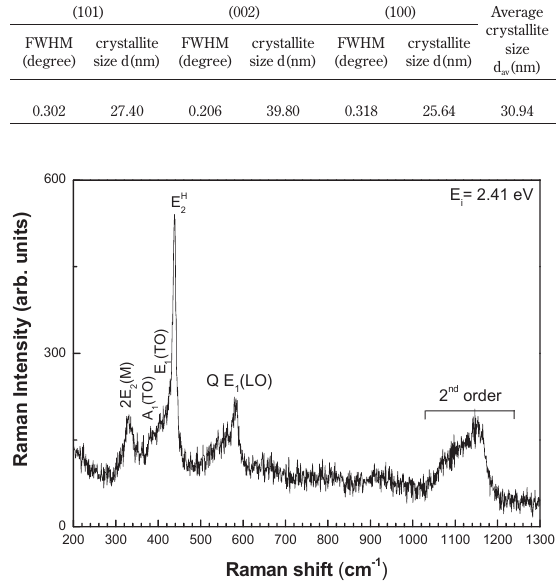
Fig. 3 Room-temperature Raman backscattering spec- trum of the nanocrystalline ZnO flakes.